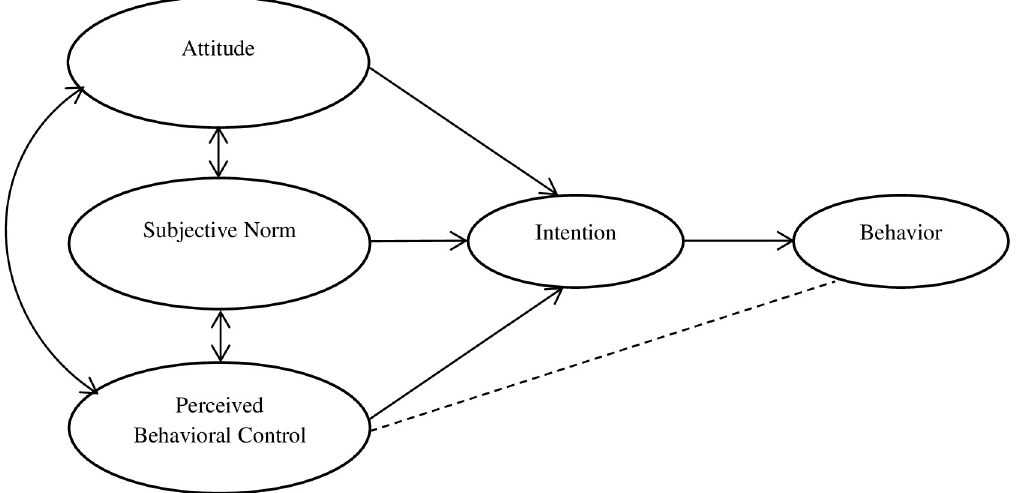
Fig 1. Theory of Planned Behavior [Adopted from Ajzen, I.